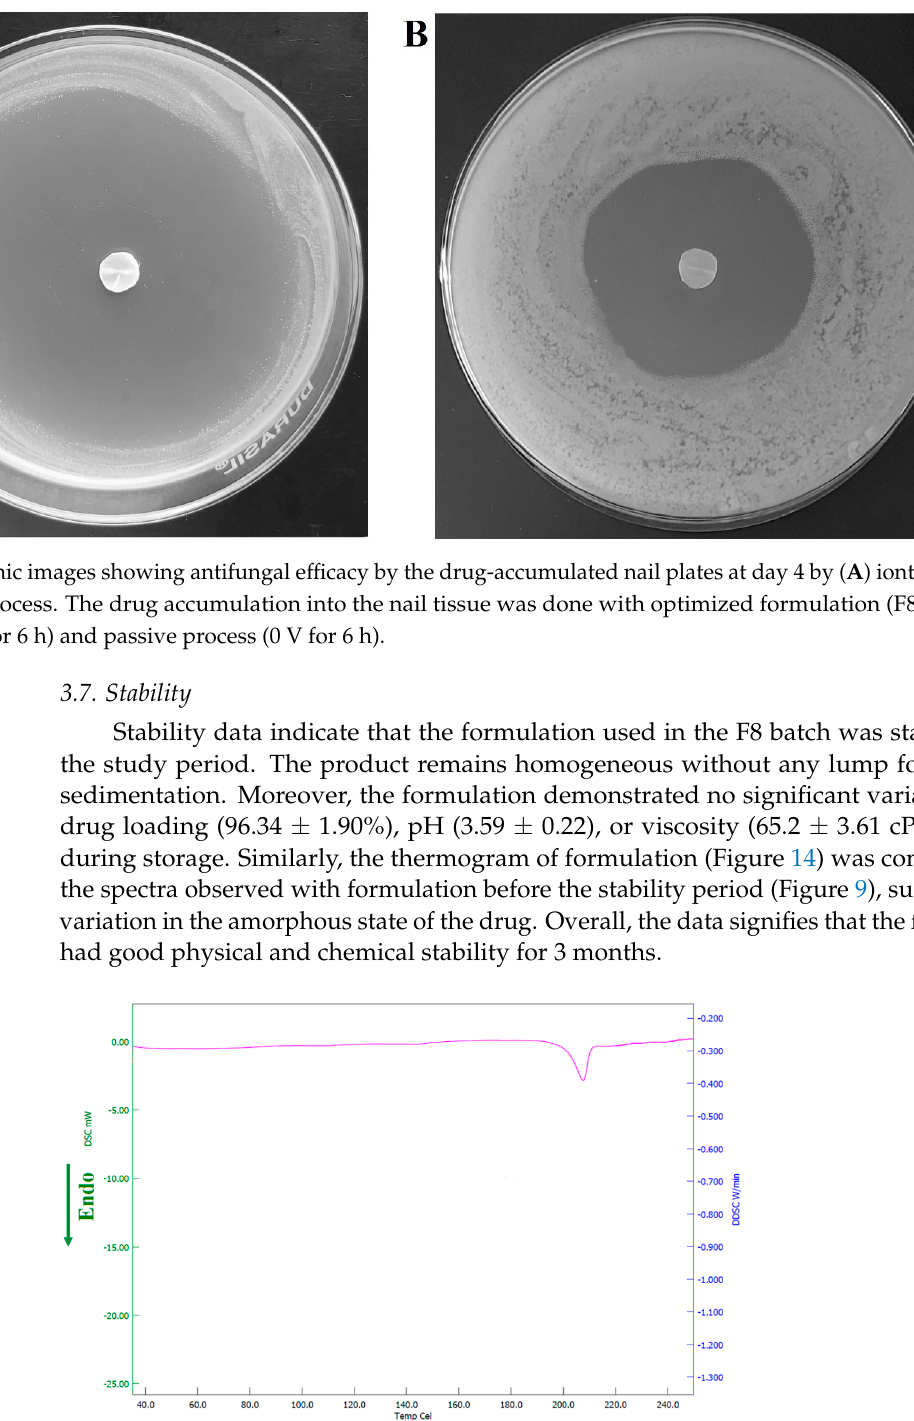
Figure 14. Differential scanning calorimetric patterns of optimized batch (F8) after stability testing.